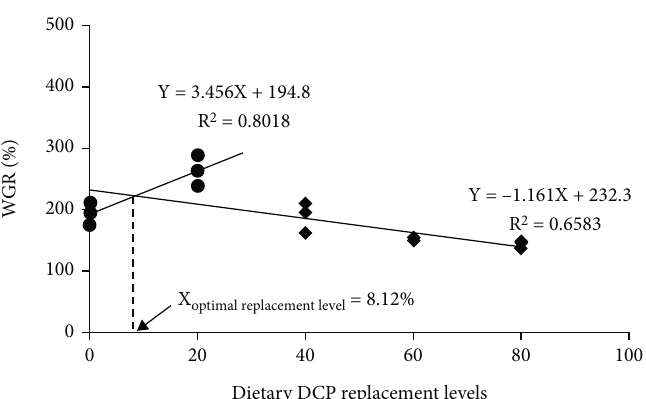
Figure 2: The broken line model for the relationship between WGR and dietary DCP replacement levels of juvenile large yellow croaker fed the trial diets.